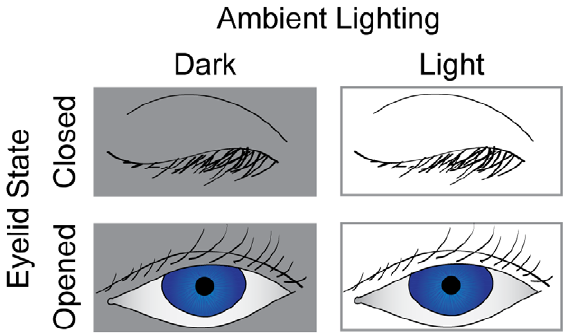
Figure 1. Grating orientation task (GOT). A. Participants were seated upright with their tested hand resting in prone position on a tabletop. In Experiments 2 and 3, a box occluded the participant’s tested hand from view. B. In each trial, a grating stimulus contacted the tested finger pad twice, once with the gratings aligned vertically, and once with the gratings aligned horizontally. The images in A and B are not drawn to scale.